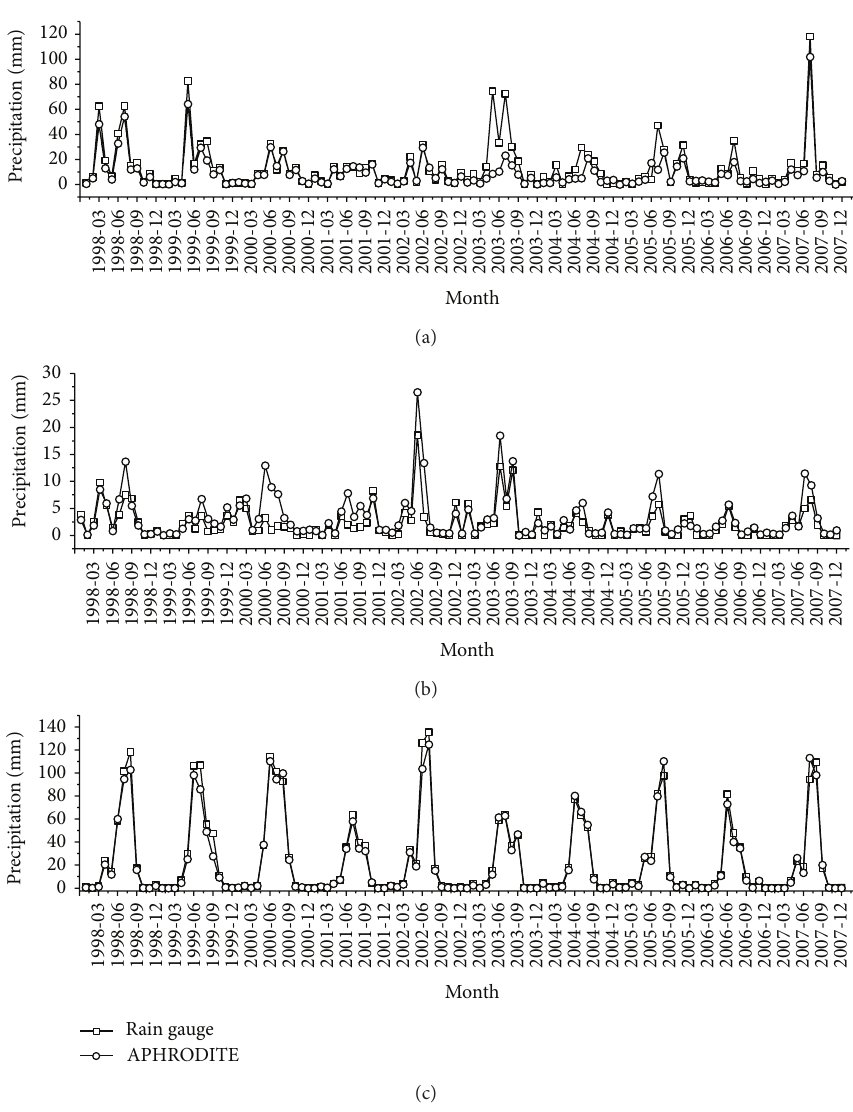
Figure 5: Average monthly precipitation of the 3 selected stations and grid boxes, respectively ((a) YW, 𝑅 = 0.59 ; (b) TRP, 𝑅 = 0.8 ; and (c) BLT, 𝑅 = 0.95